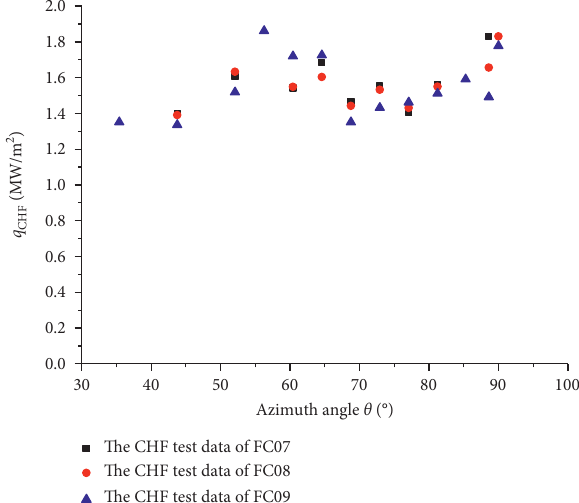
Figure 7: CHF distribution of the FC01-FC03 test conditions.